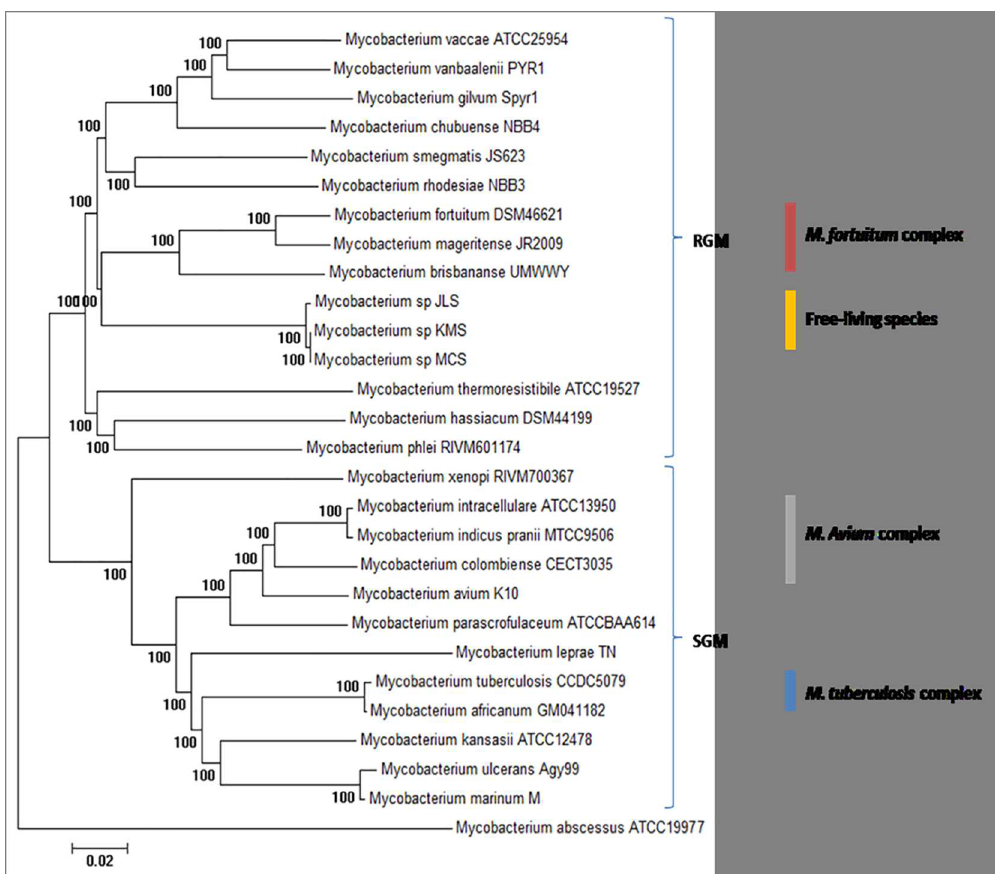
Fig 2. Phylogenetic tree of Mycobacterium species constructed using 531 core-concatenated genes. Bootstrap numbers were generatedin 1,000 runs and nodes with bootstrap support values of 100 were indicated.